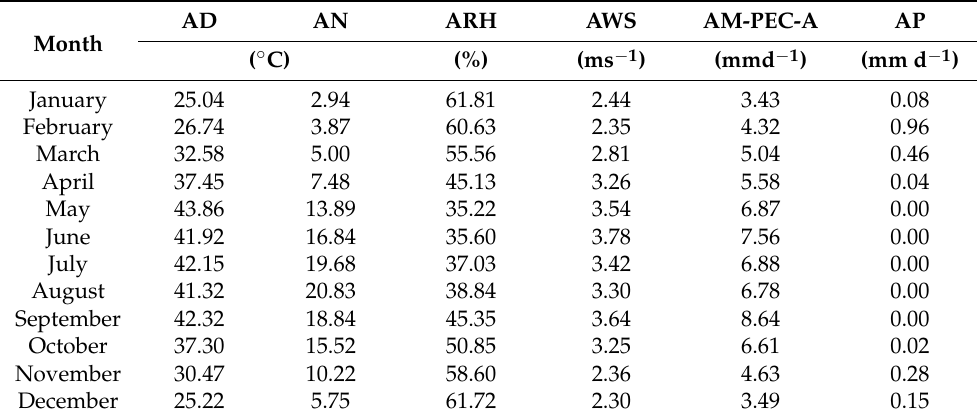
Table 1. Average climate data for Kawm Ushim region (29 ◦ 55 (cid:48) N; 30 ◦ 88 (cid:48) E), Fayoum, Egypt in 2020 and 2021 growing